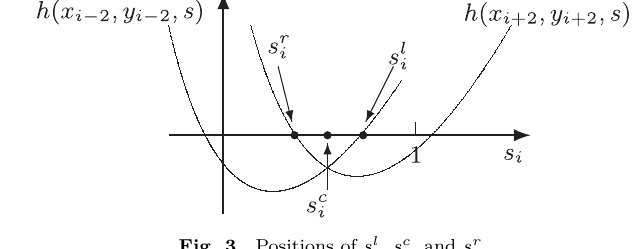
Fig. 3 Positions of s l i , s c i , and s r i